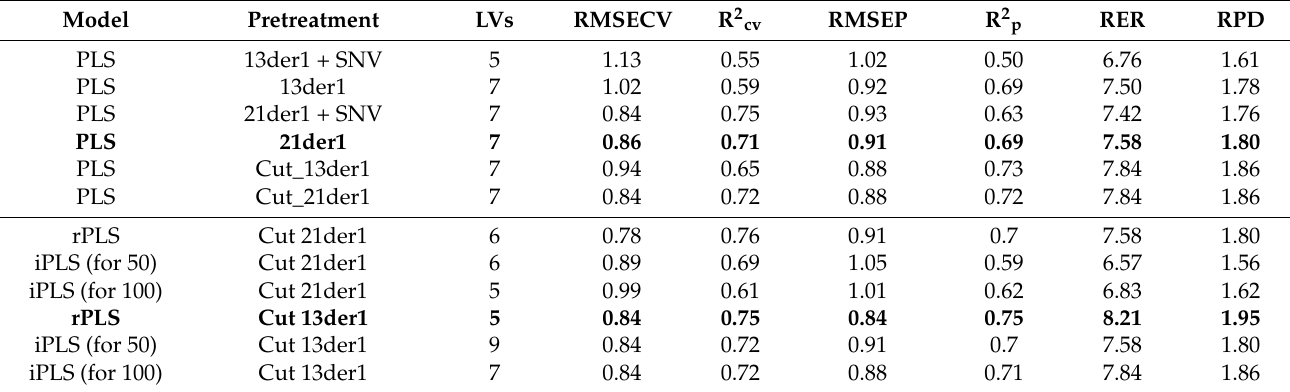
Table 2. Summary of partial least squares regression (PLS) results and summary of PLS results applying variable selection techniques to RDB-2020 for SSC ( ◦ Brix) prediction models. The best PLS models are marked in bold (xder1 = first derivative with x number of smoothing points; SNV = standard normal variate; LVs = latent variables; RMSECV = root mean square error of cross validation; RMSEP = root mean square error of prediction; RER = range error ratio; RPD = ratio of performance to